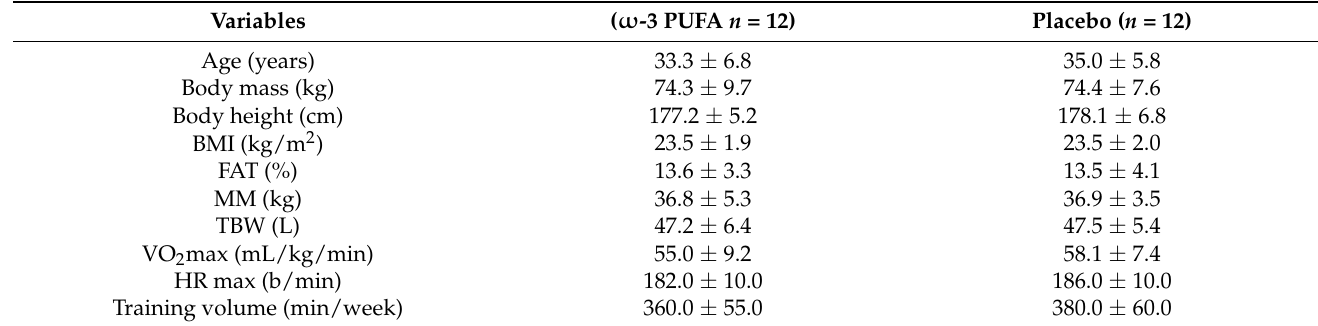
Table 1. Participants’ characteristics (mean, SD).